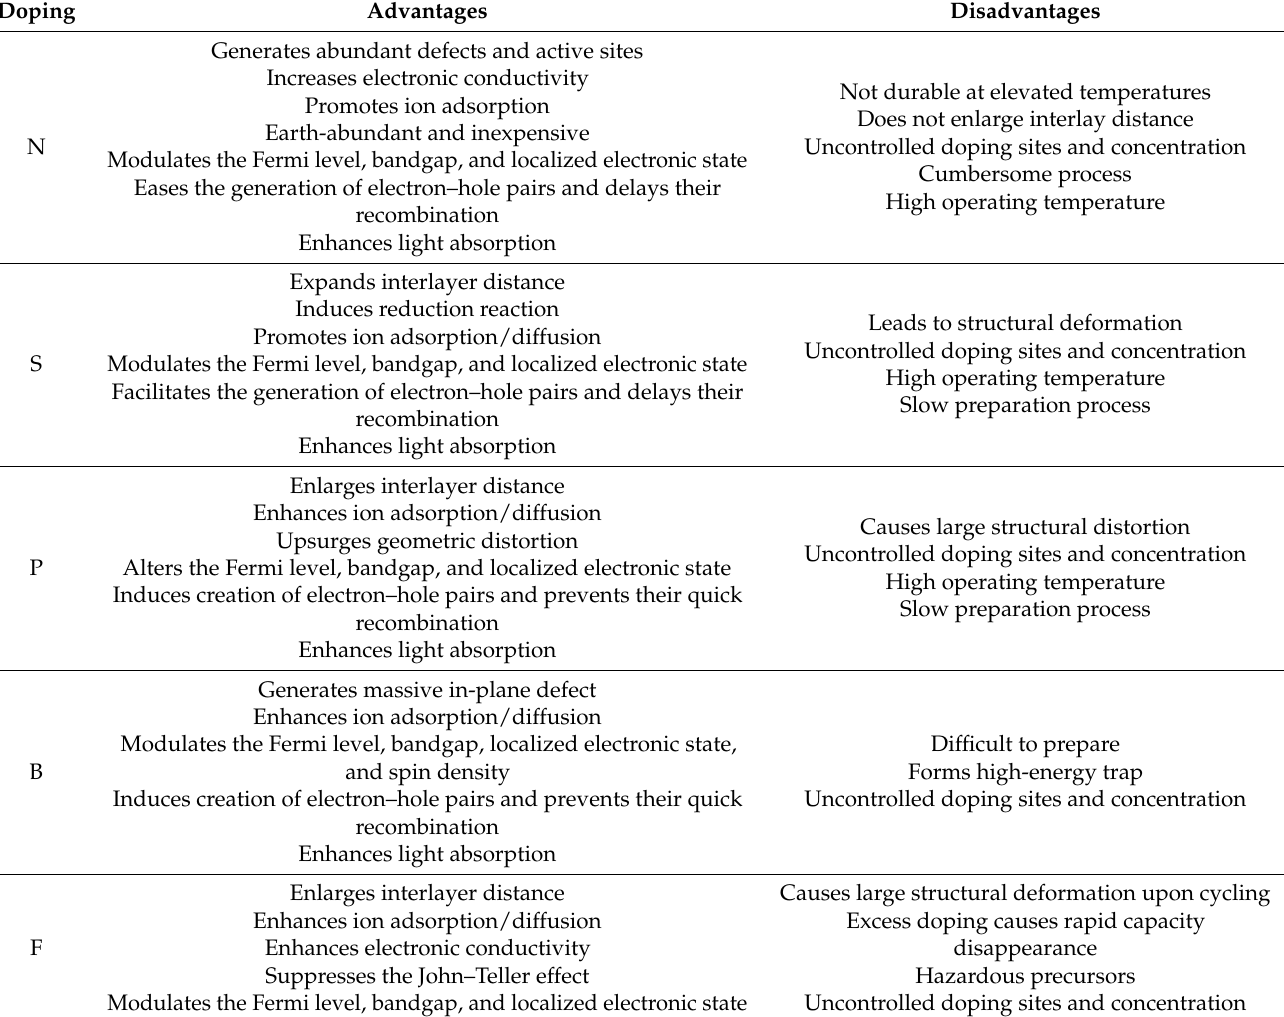
Table 4. Comparison of the advantages and disadvantages of mono-heteroatom-doped porous